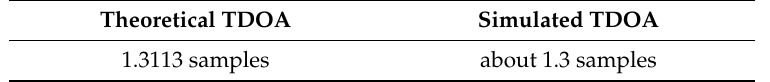
Table 2. Comparison of the time difference of arrival (TDOA) for theoretical and simulated values.